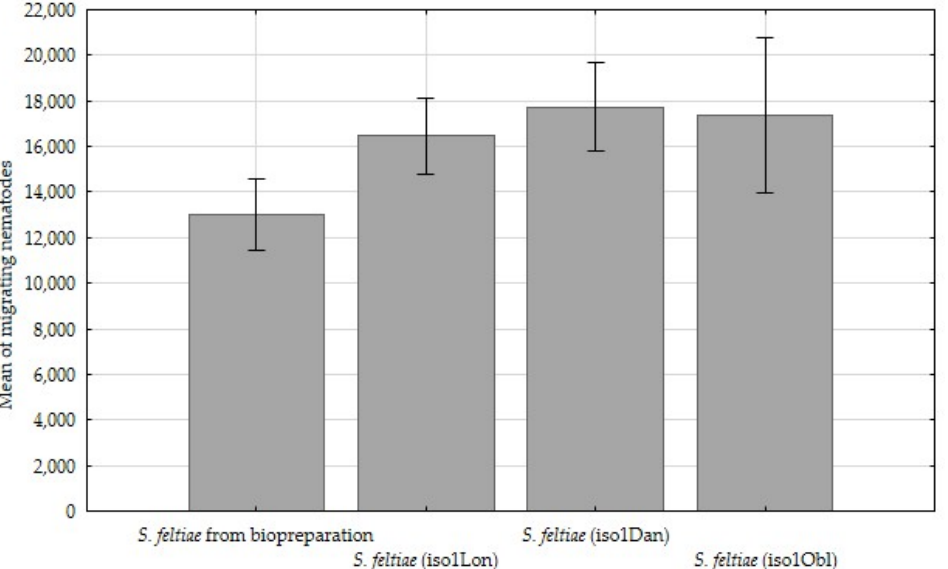
Figure 4. Comparison of mean of migrating nematode juveniles from host insects from the different Steinernema feltiae isolates, ±standard deviation (SD).